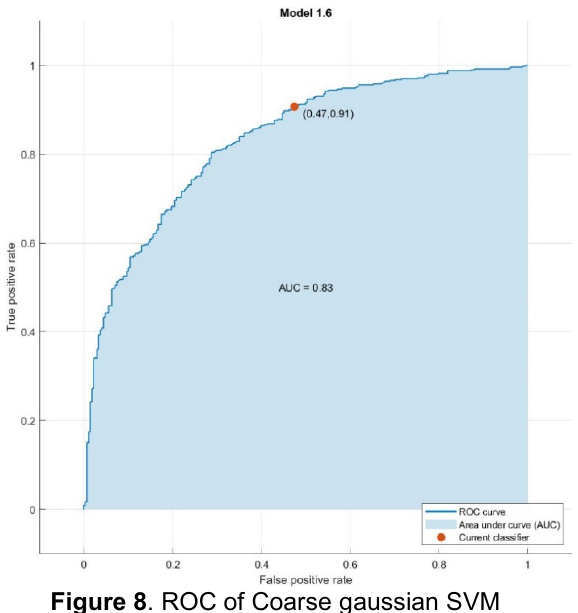
Figure 8 . ROC of Coarse gaussian SVM